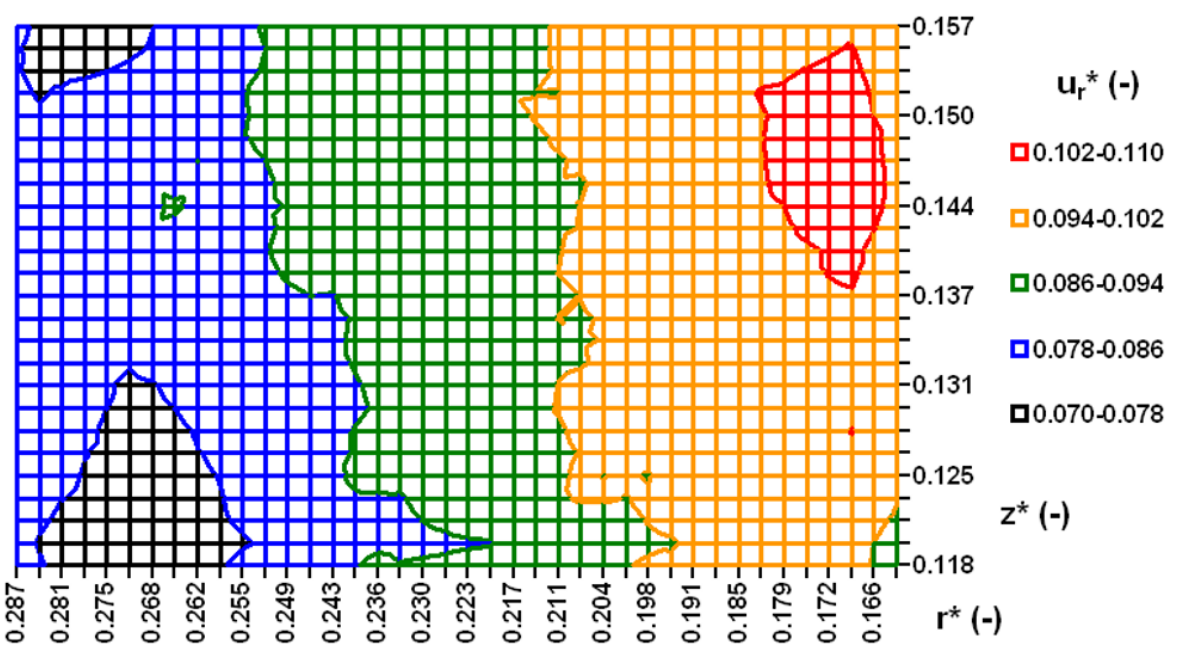
Fig. 4. Dimensionless radial fluctuation velocity distribution u r* = )/( NDu